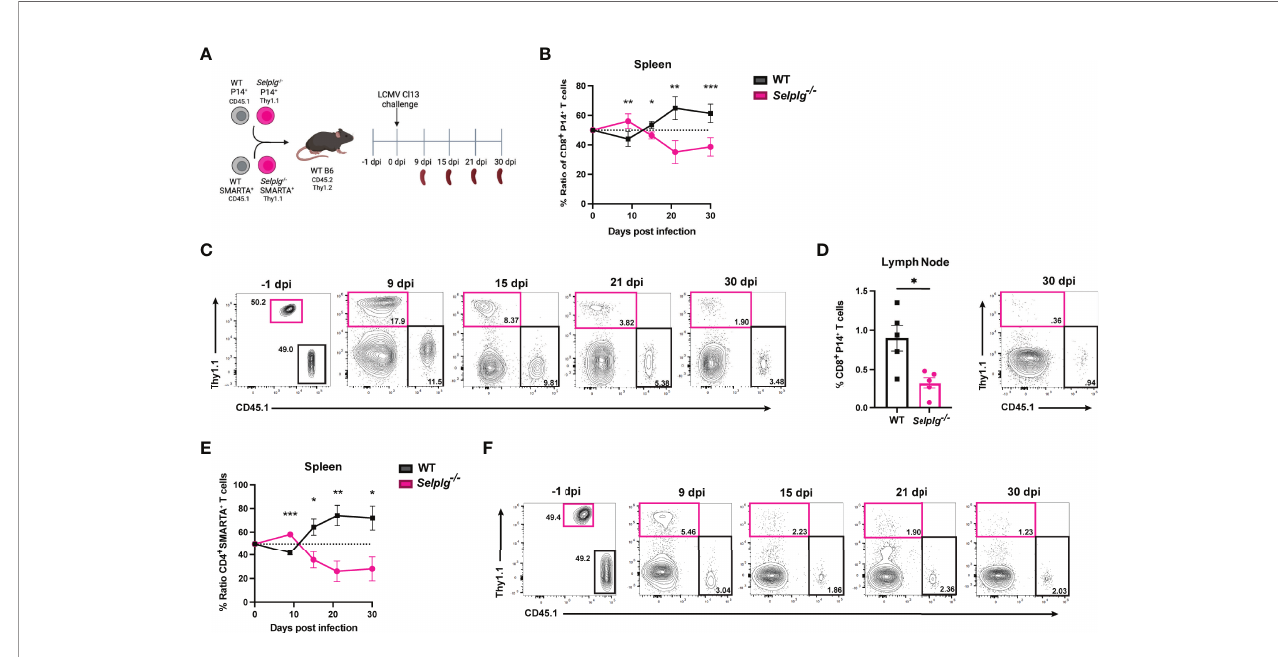
FIGURE 1 | Selplg -/- CD4 + and CD8 + T cell kinetics over the course of chronic viral infection. WT and Selplg -/- P14 and SMARTA T cells were adoptively transferred at equal ratios into naïve WT recipients and infected with Cl13 one day after (A) . Ratio of WT and Selplg -/- P14 T cells in the spleen at the indicated timepoints (B) and representative FACs plots (C) . Frequencies of WT and Selplg -/- P14 T cells in the lymph nodes at 30dpi (D) . Ratio of WT and Selplg -/- SMARTA T cells in the spleen (E) and representative FACs plots (F) . *p < 0.05, **p < 0.01, ***p < 0.001, (unpaired t -test). Data are representative of four independent experiments all with fi ve or more mice per group (error bars,